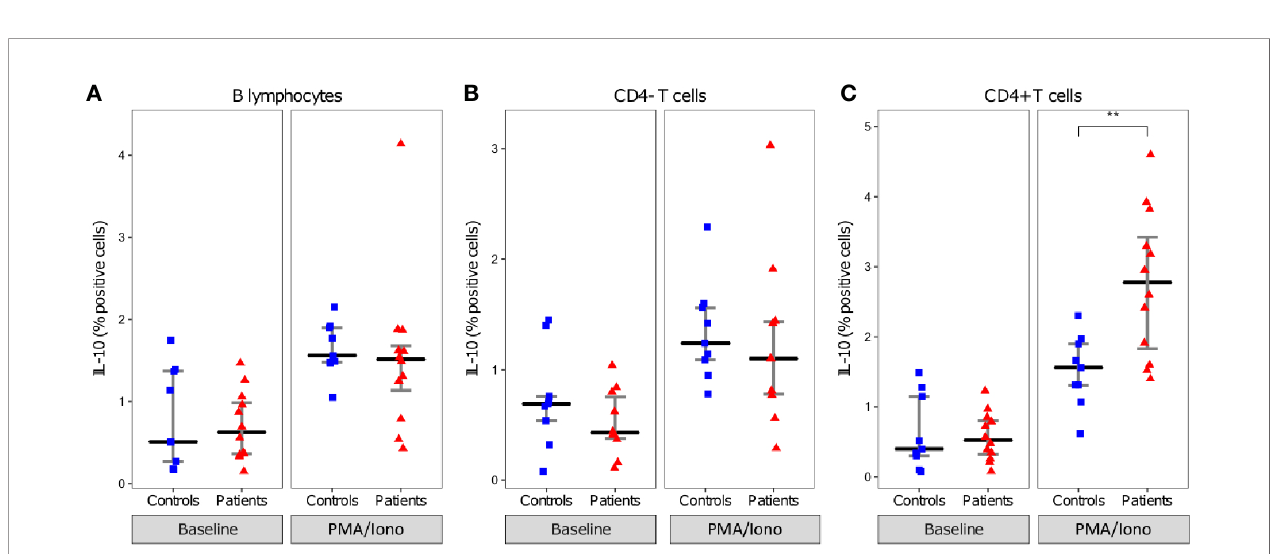
FIGURE 4 | Intracellular IL-10 expression in lymphocytes. Proportion of IL-10 positive B lymphocytes (A) , CD4- T cells (B) , and CD4+ T cells (C) . lymphocytes presented as individual values in healthy donors (n=9; blue squares) and septic patients (n = 12; red triangles) and medians ± IQR, with (PMA/Iono) and without (Non stimulated) PMA/Iononmycin challenge. **p < 0.01 with Mann-Whitney U